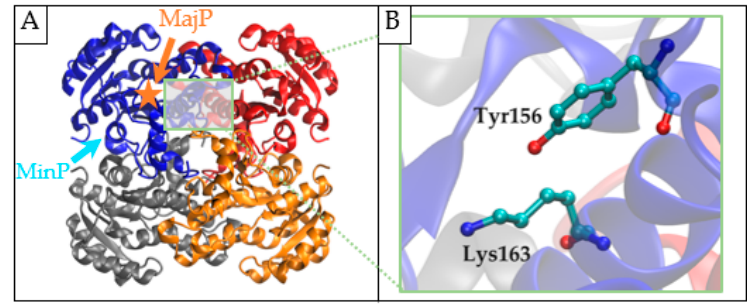
Figure 24. ( A ) Ec FabI apo structure (PDB ID 2FHS). The FabI monomers are coloured in blue, red, grey and orange. The AcpPs present in the structure were removed for clarity. The orange star sym- bolises the major portal (MajP), and the blue arrow represents the entry of the minor portal (MinP). ( B ) View of the active site of Ec FabI (PDB ID 2FHS). This view is focused on the two catalytic resi- dues Tyr156 and Lys163.